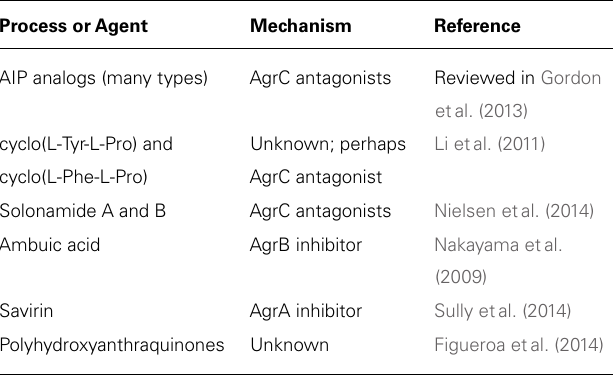
Table 1 | Examples of reported inhibitors of the Staphylococcus aureus agr